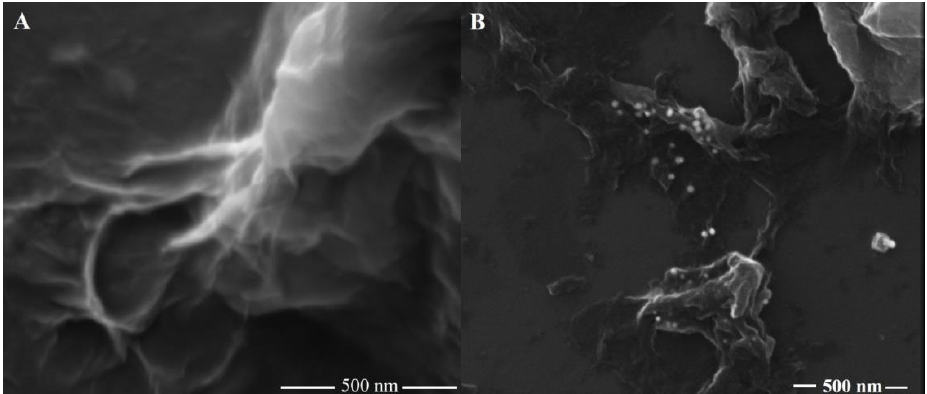
Figure 1. FEG-SEM micrographs for: ( A ) rGO and ( B ) rGO-AuNPs composite.